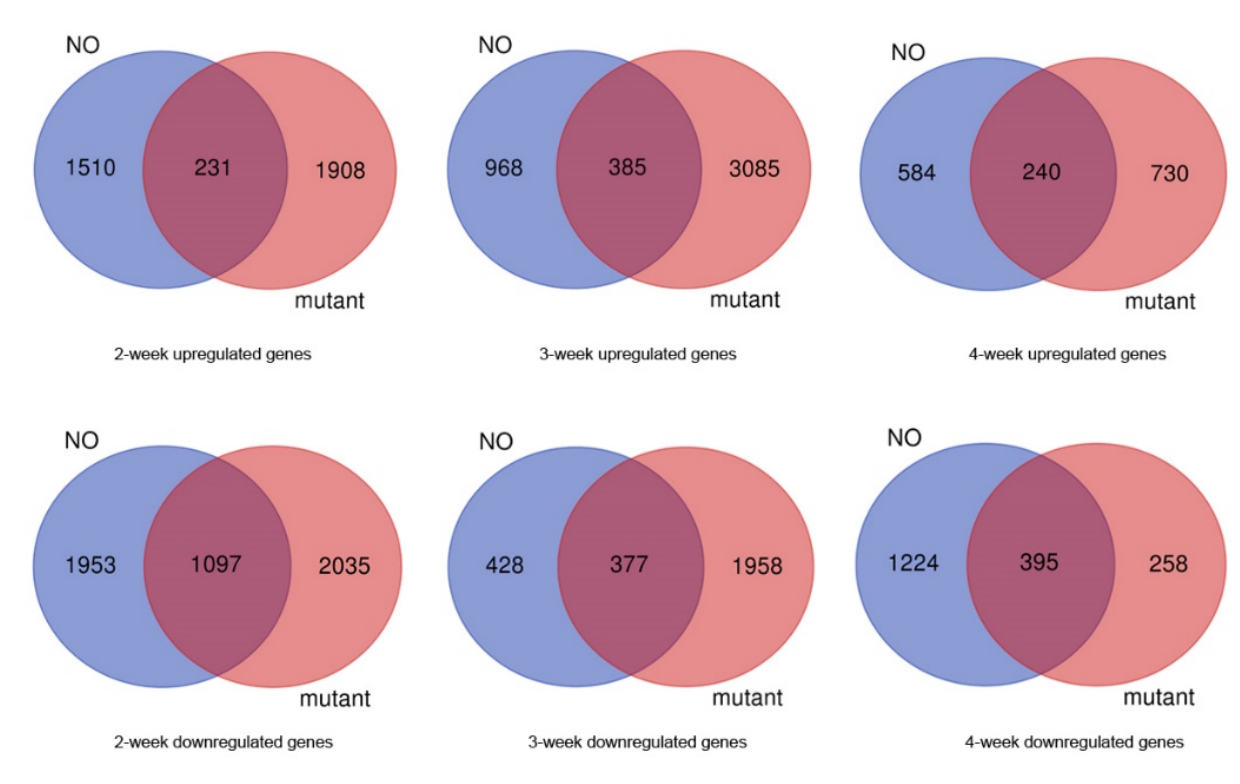
Figure 5 Transcriptome analysis of FHY3/FAR1-regulated genes. The Venn diagram shows the overlap of upregulated and downregulated genes in NO and fhy3 far1 samples under various stages. The numbers in the circles indicate the number of genes changed in each